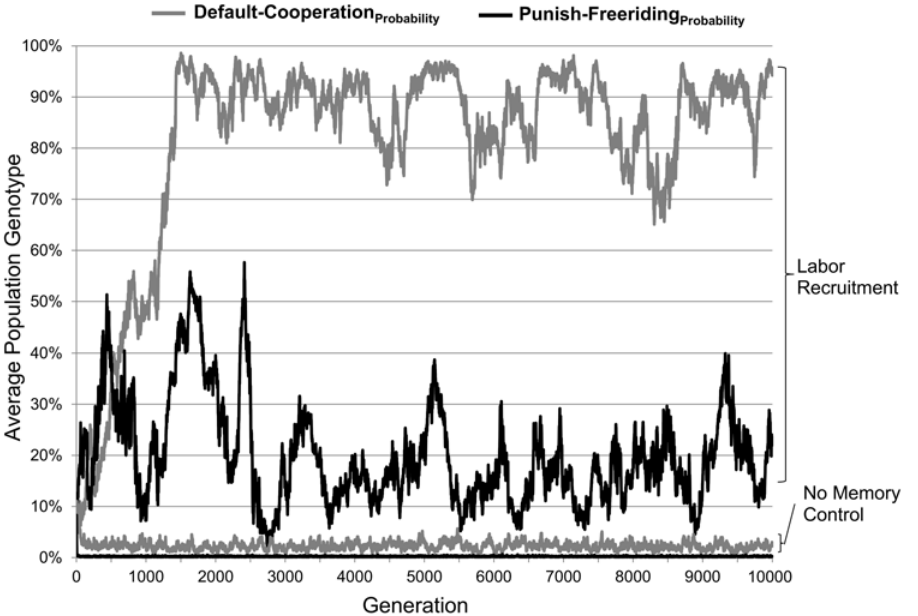
Fig 1. Sample evolutionary dynamics. This figure plots the average level of Default-Cooperation Probability and Punish-Freeriding Probability over generations from one representative simulation run from the original simulation and from the no-memory control. For these runs group size = 5, b = 0.8, expected encounters = 50, and it was a mixing